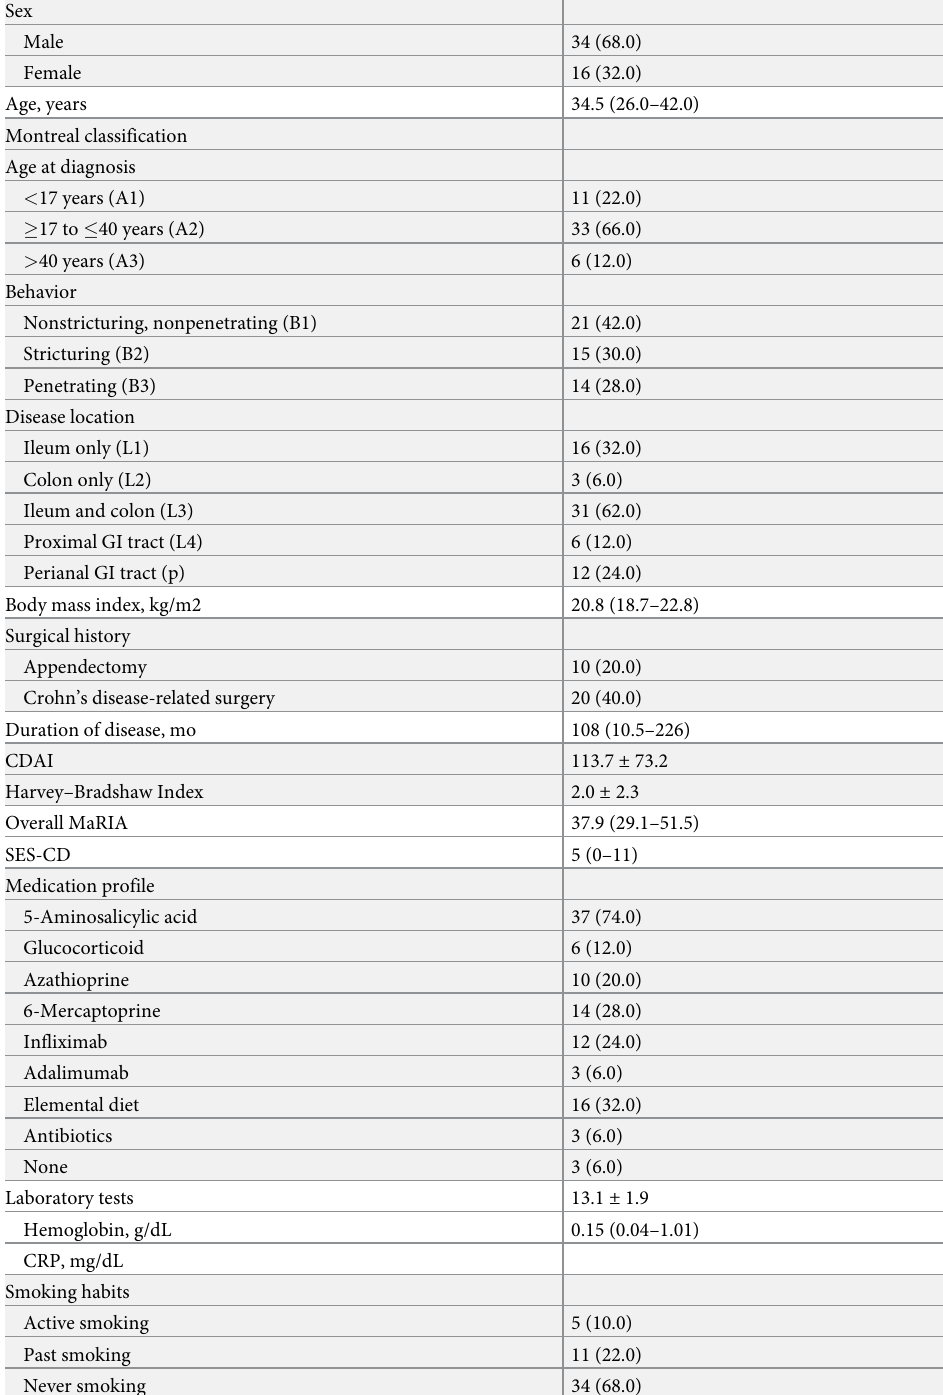
Table 1. Patients’ characteristics ( n =